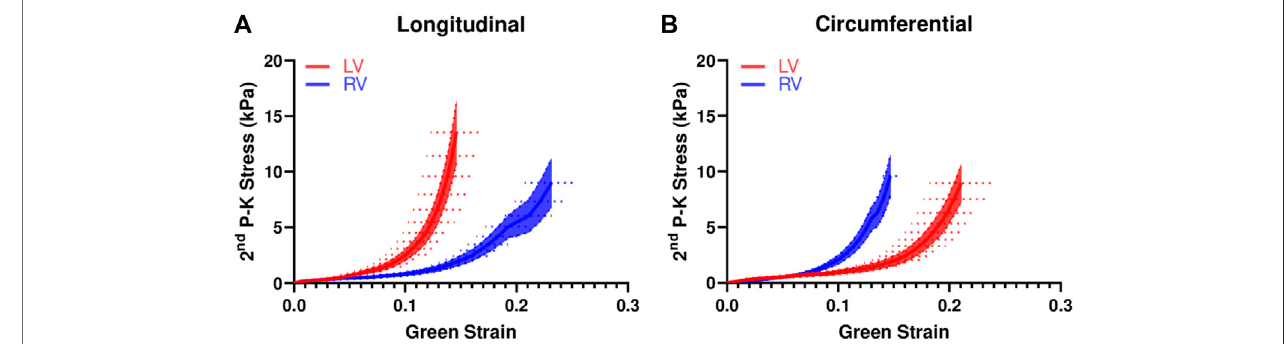
FIGURE 2 | Average equibiaxial stress-strain curves in the longitudinal (A) and circumferential (B) directions in the LV and RV ( n = 7 per group). The shaded area is the standard error of the stress data, and the dash line is the standard error for the strain data.